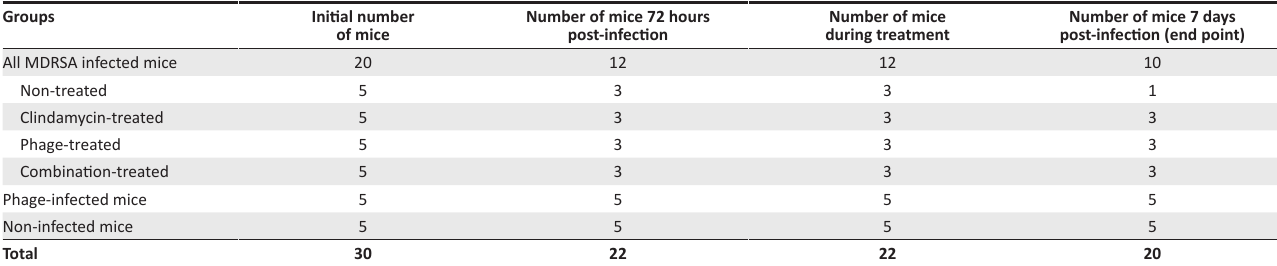
TABLE 1: Number of surviving mice at 72 hours post-infection and 7 days post-treatment, Nairobi, Kenya. Groups